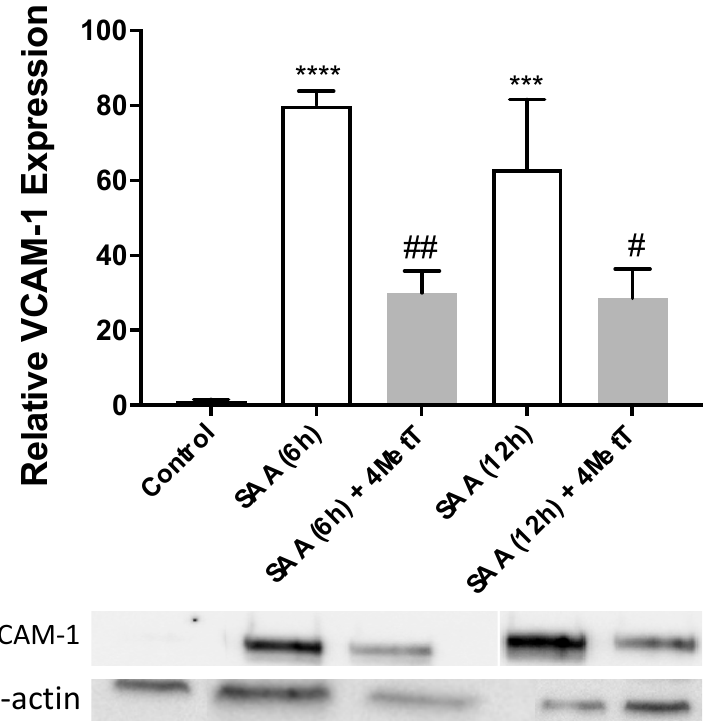
Figure 4. Effect of SAA and 4-MetT on vascular cell adhesion molecule-1 (VCAM-1) protein expression in cultured primary HAEC. VCAM-1 protein expression in HAEC was assessed by means of Western blot analysis. Lysates were generated from cells that were treated with 10 µg/mL SAA at either 6 or12 and with or without 25 µM 4-MetT preincubation for 24 h prior to adding SAA, or DMSO (vehicle control) and proteins were separated via SDS-page. The resultant membrane was then immunoblotted with an anti-VCAM-1 primary and secondary antibody pair. Data represent mean ± SD, n = 3 independent biological replicates. *** p = 0.0001; **** p < 0.0001. Different to control in the absence of SAA, # p < 0.05; ## p < 0.001 Different to SAA-treatment group.